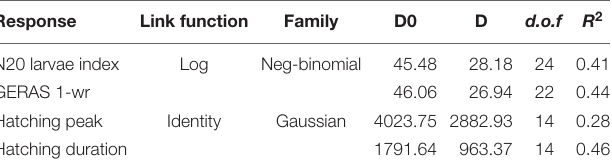
TABLE 1 | Fit statistics of the best candidate models for the N20 larvae index, GERAS 1-wr, hatching peak, and hatching